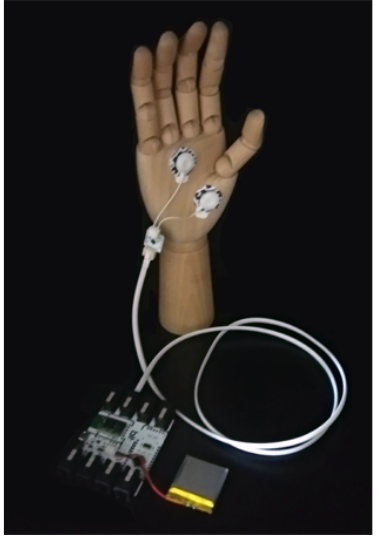
Figure 1. Electrodes placement for GSR